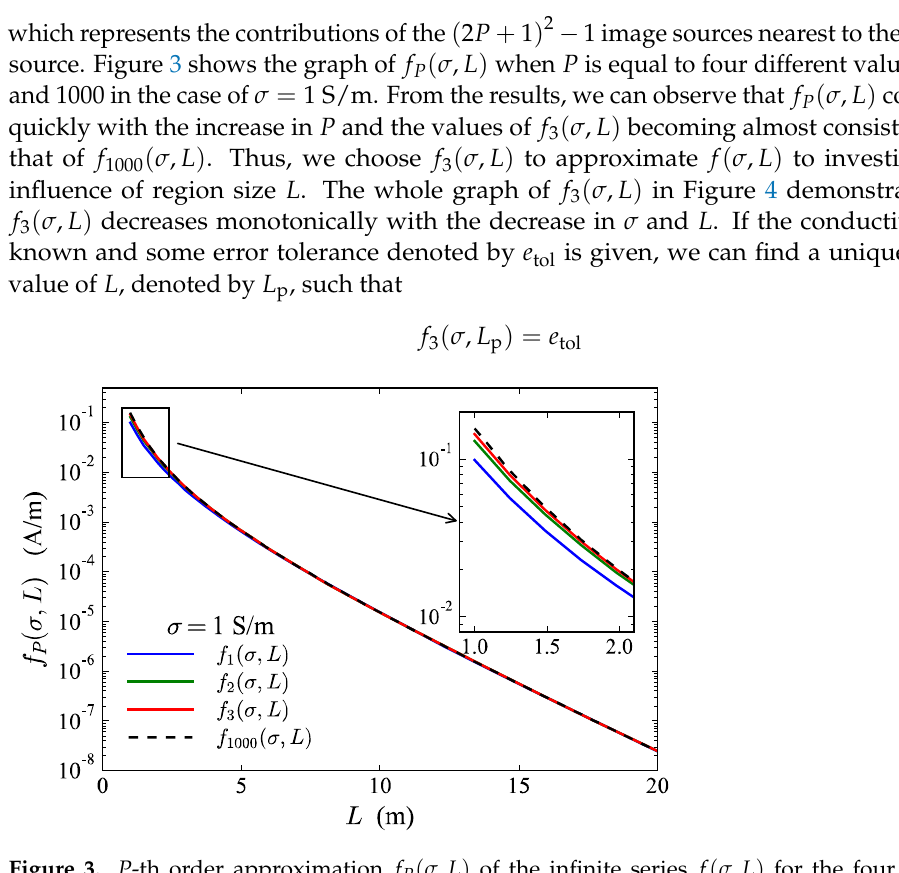
f L  of the infinite series ( , ) f L  for the four different P